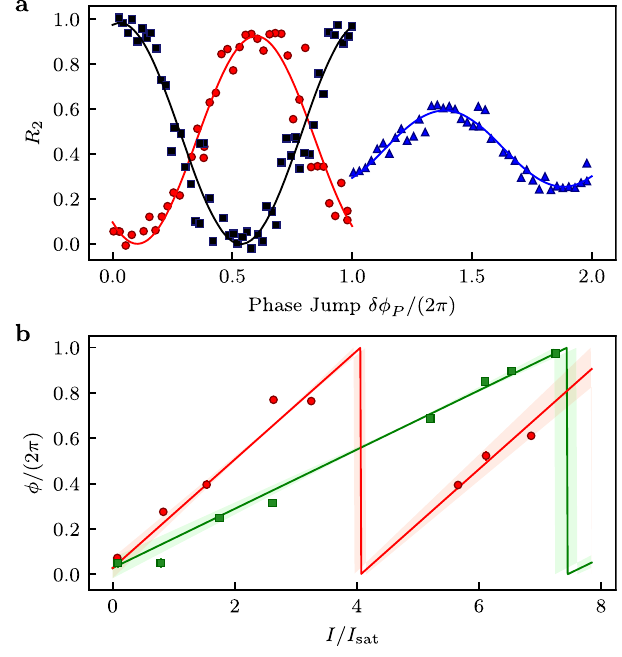
Fig. 2 Ramsey interferometry data. a Ramsey oscillation without (black squares) and with the light pulse at (cid:2) δ ¼ 63 : 4 and (cid:2) I (cid:9) 2 (red circles) and (cid:2) I (cid:9) 7 (blue triangles), taken in situ as the phase jump δϕ P between the two pulses is varied. Solid curves are fi ts to the equation given in the text. Blue Ramsey data δϕ P values are deliberately shifted by 2 π to visualize the reduction in contrast and the larger phase shift. b Optically induced phase shift ϕ as a function (cid:2) I at (cid:2) δ ¼ 63 : 4 (red circles) and (cid:2) δ ¼ 116 : 2 (green squares). The same-color lines are fi ts to (cid:5) V ac t m = _ mod 2 π . Shaded regions indicate the ±1 σ statistical uncertainty